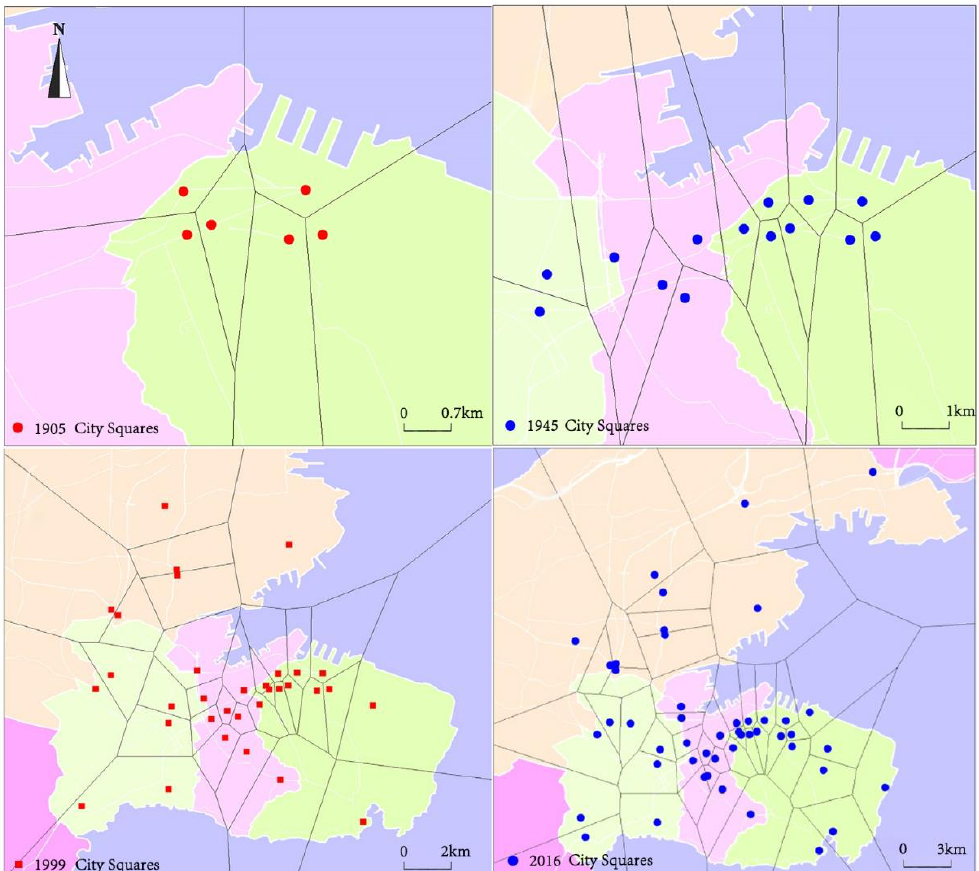
Figure 4. Voronoi diagram of city squares.